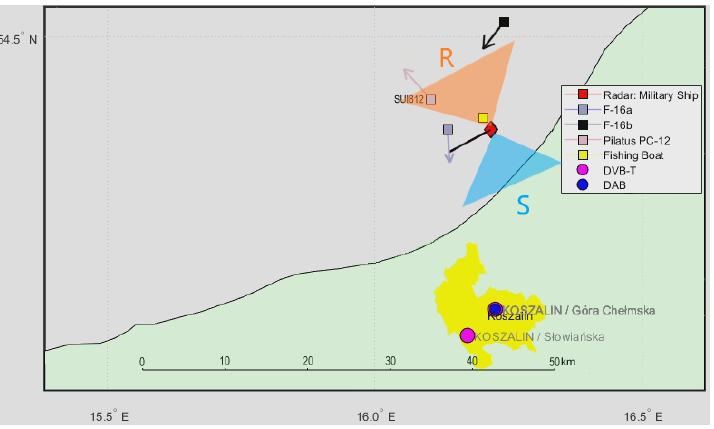
Figure 20. Situation map of the PILATUS PC-12 and two F-16 jet fighters.